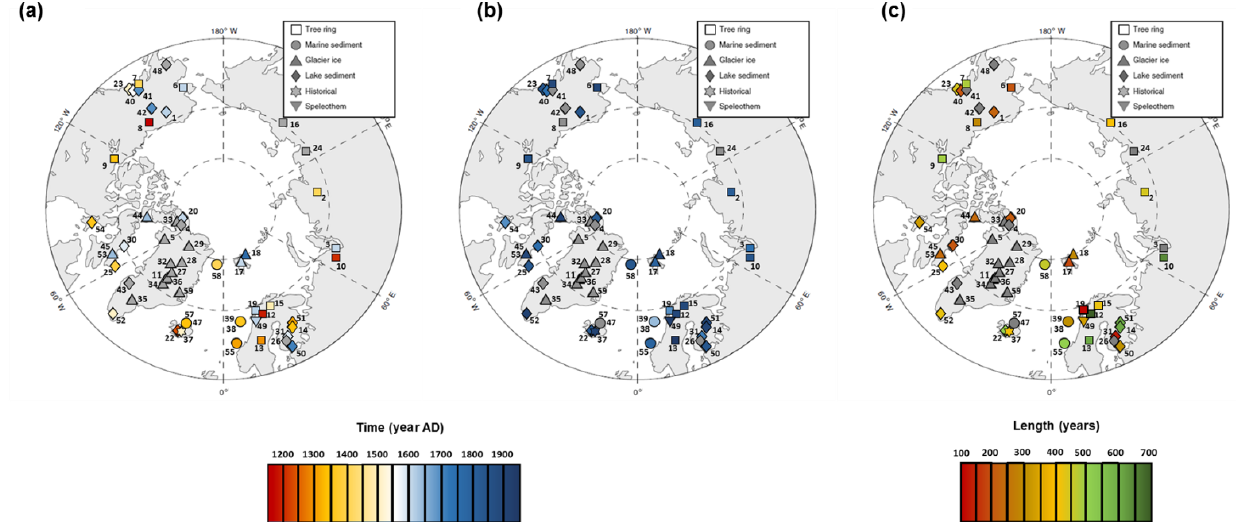
Figure 7. Spatial expression of the Little Ice Age (LIA) of the Arctic 2k series based on a reference paper (see McKay and Kaufman, 2014): starting (a) , ending (b) and length (c) . Symbols in grey correspond to series for which the LIA is not mentioned by the authors in the original publication. More details concerning the temporal expression of the LIA are available in Table S3 and Fig.